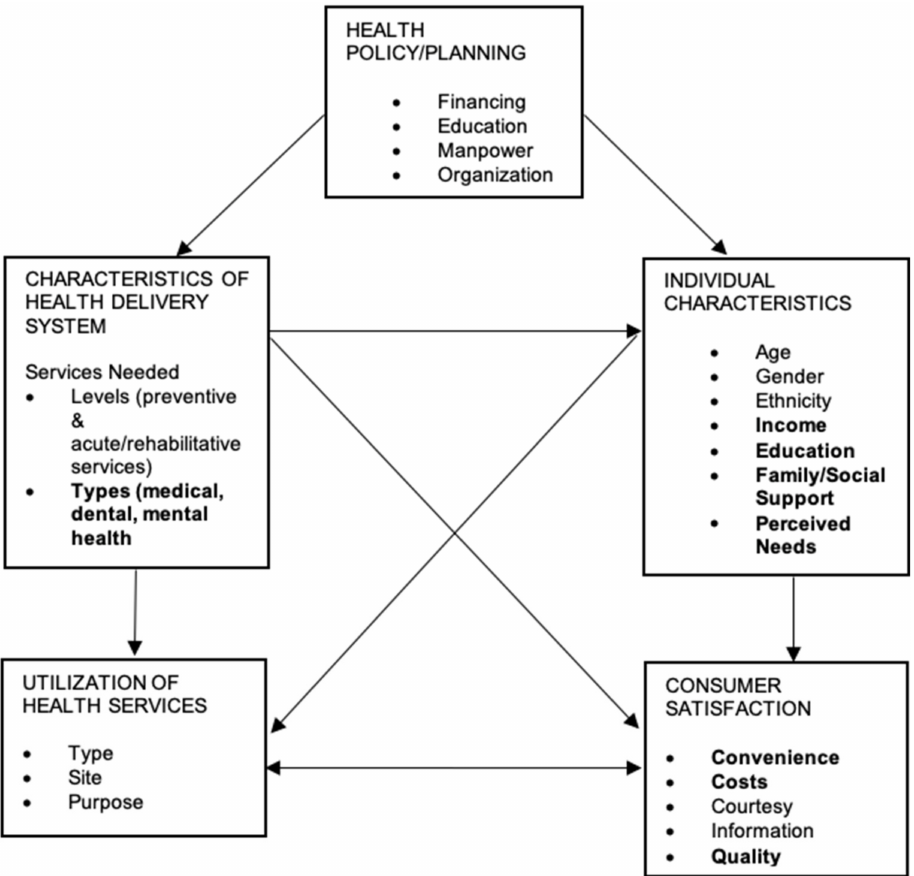
Figure 2. Conceptual framework of access adapted from Aday and Andersen (1974) [47]. Factors highlighted in bold are the main findings from this